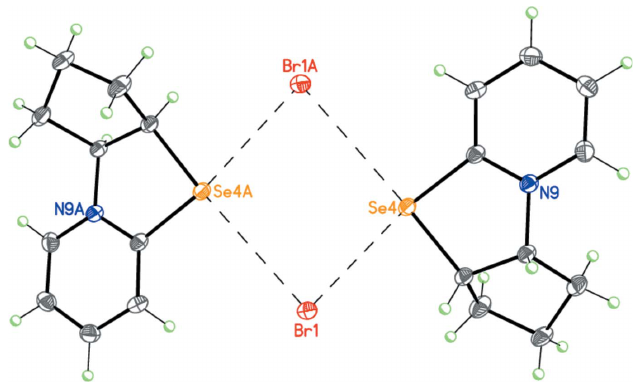
Figure 8 Dimeric structure of 2 . Dashed lines indicate the intermolecular non- covalent Se (cid:3)(cid:3)(cid:3) Br interactions. [Symmetry code: (A) ???]